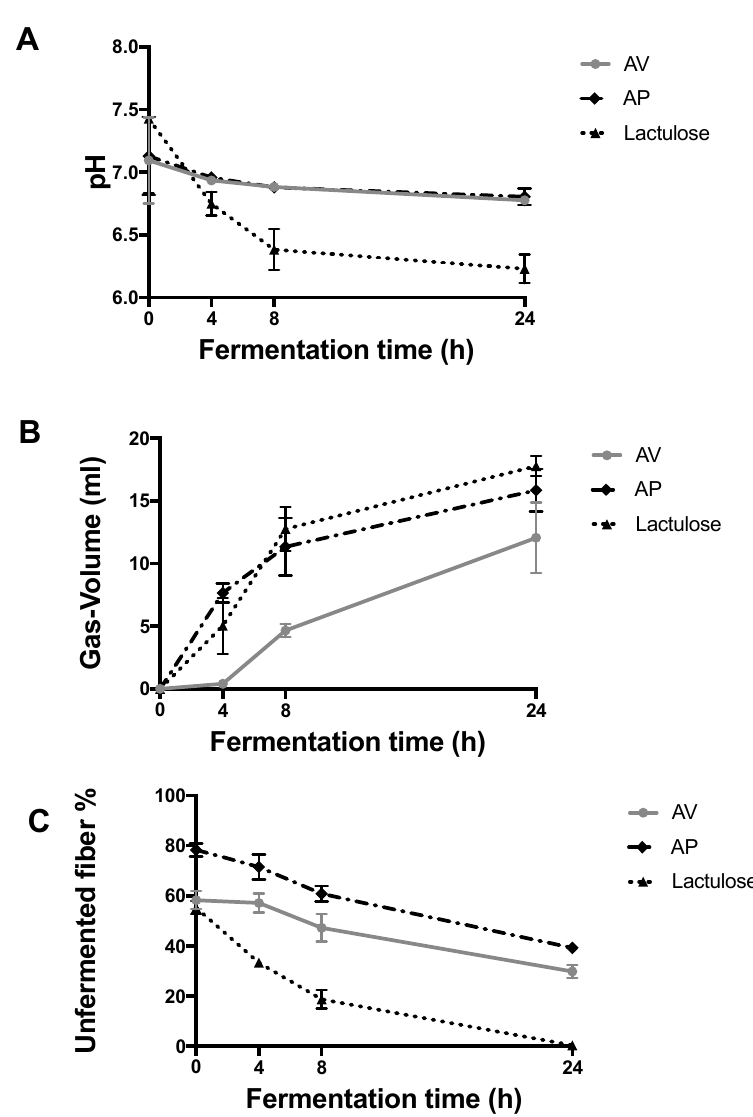
Figure 2. Fermentation kinetics of Aloe vera gel (AV) and its polysaccharide extract (AP) during 24 h. ( A ) pH changes during fermentation, ( B ) Volume of gas produced during fermentation, and ( C ) Unfermented residue of samples AV and AP.